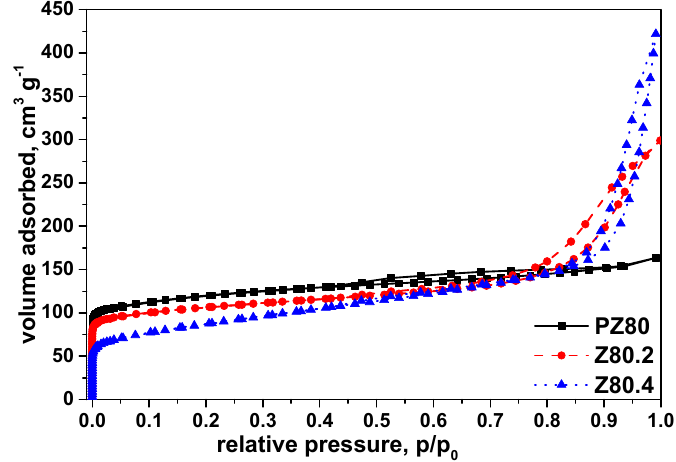
Figure 4. N 2 isotherms of PZ80 (black square, full line), Z80.2 (red circle, dashed line), and Z80.4 (blue triangle, dotted line) at 77 K.